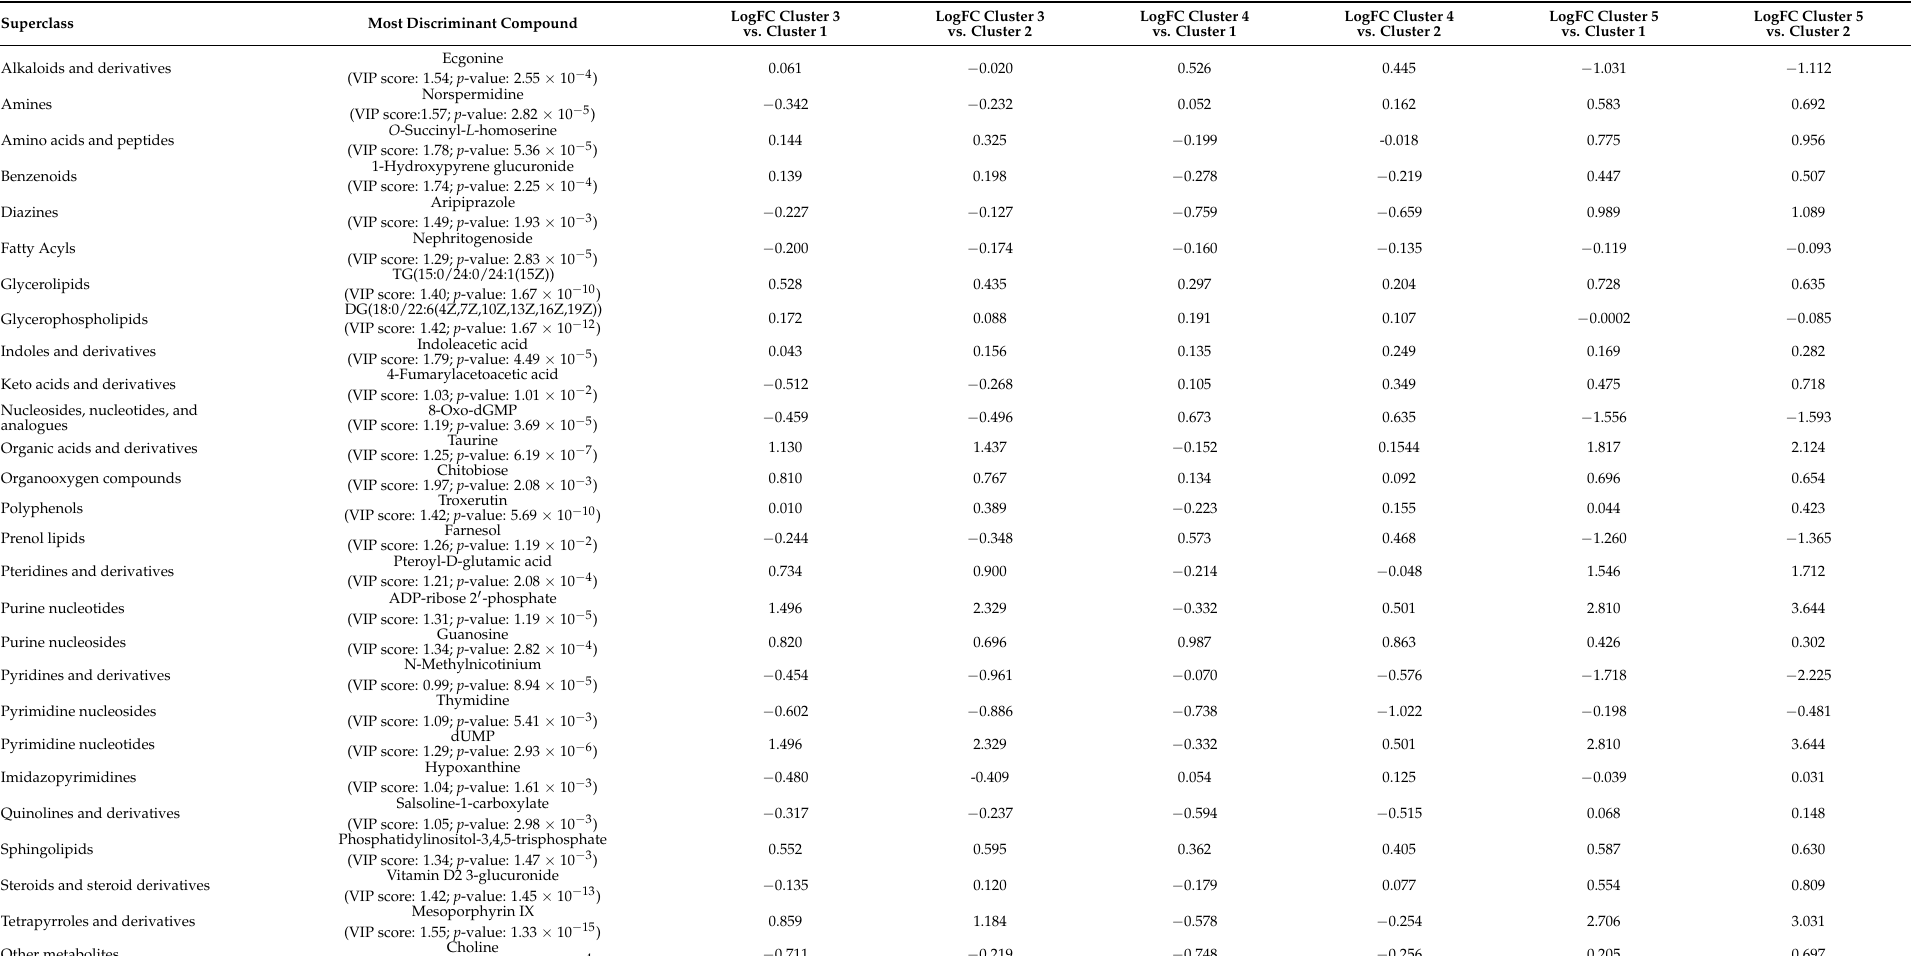
Table 3. Pairwise comparisons of milk samples from contaminated (i.e., cluster 3, 4, and 5) and low-contaminated corn silage clusters (i.e., cluster 1 and 2). The variations of the main classes are expressed as average Log2 fold-change (FC) values. The most discriminant compounds according to the OPLS-DA prediction model built (VIP score > 1) together with their adjusted p -values (resulting from Volcano plot analysis and family-wise error rate) are also reported.